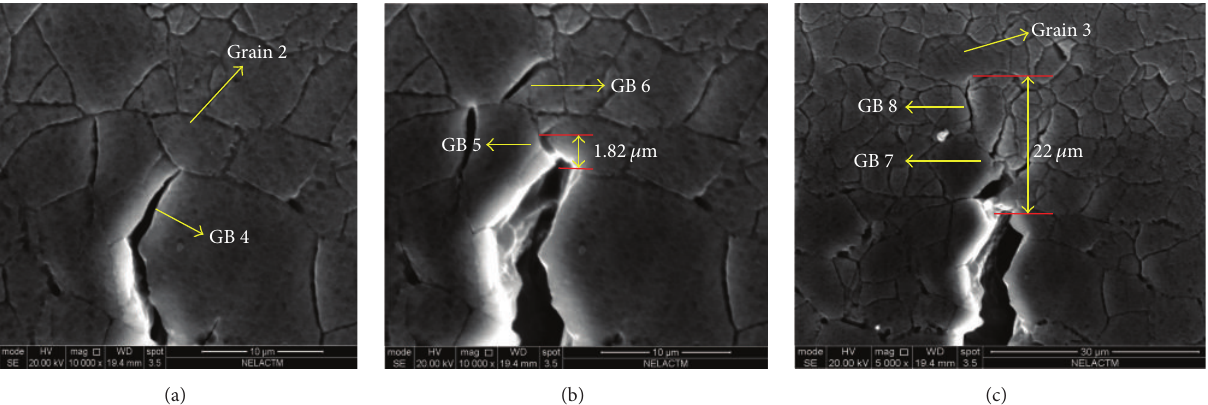
Figure 9: Micromorphology of fatigue crack at different loading cycles: (a) at 114 cycles, (b) at 116 cycles, and (c) at 119 cycles.